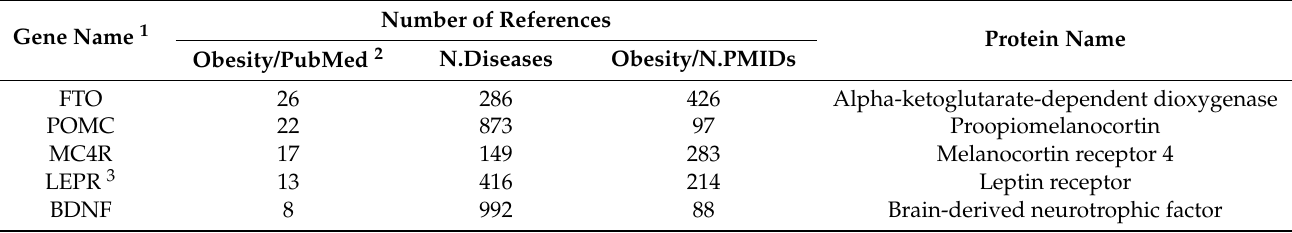
Table 1. Top five genes related to the Mendelian forms of obesity, selected according to the number of gene-associated PubMed abstracts. N.Diseases and N.PMIDs were retrieved as a result of the DisGeNET search for a given gene, and denote the numbers of diseases and PubMed identifiers,